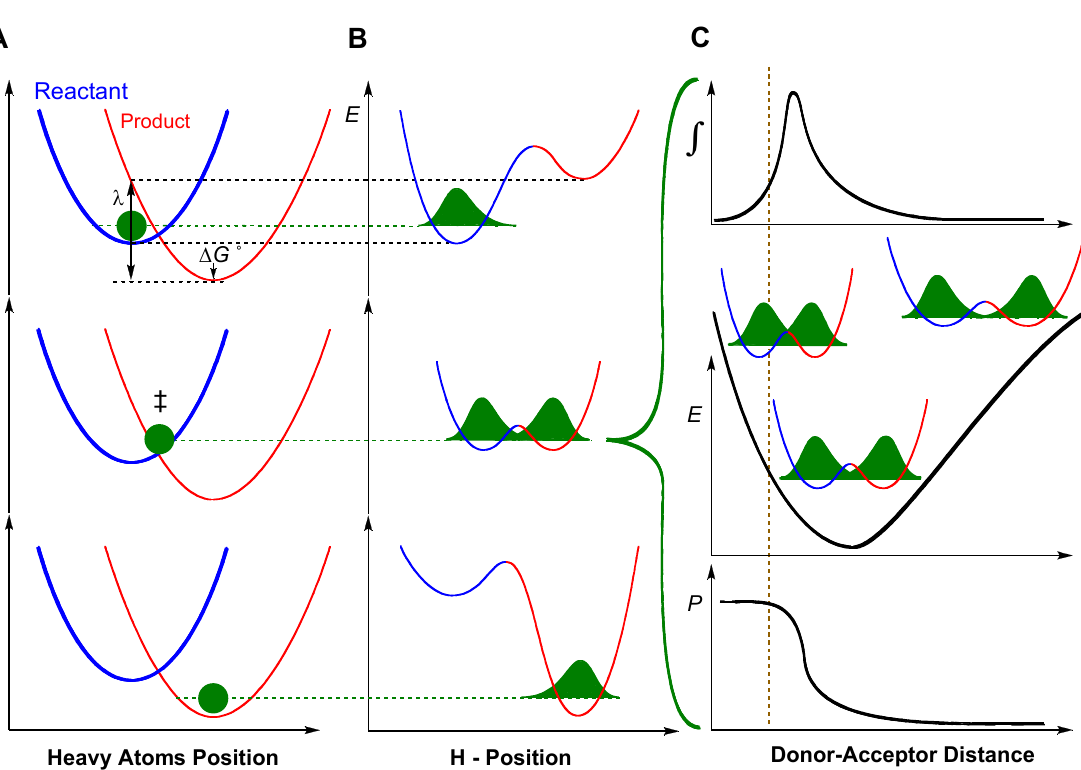
Figure 4. Marcus-Like models of hydrogen tunneling—a visualization of Equation (21). Three slices of the potential energy surface (PES) along components of the collective reaction coordinate showing the effect of heavy-atom motions on the zero point energy in the reactant (blue) and product (red) potential well. Panel A presents the heavy atom coordinate (also known as the Marcus parabolas), and Panel B shows the H-atom position, which is orthogonal to the heavy atom coordinate. In the top panels the hydrogen is localized in the reactant well, and the zero point energy of the product state is higher than that of the reactant state. Heavy atom reorganization brings the system to the tunneling ready state (TRS, middle panels A and B ), where the zero point energy in the reactant and product wells are degenerate and the hydrogen can tunnel between the wells. Further heavy atom reorganization breaks the transient degeneracy and traps the hydrogen in the product state (bottom panels). The rate of reaching the TRS depends on the reorganization energy ( λ ) and driving force ( Δ G°), which are indicated in the top panel, and further discussed under Equation (21). Panel C shows the effect of DAD sampling on the wave function overlap at the TRS (middle panel). Transmission probability ( P ) is a function of the overlap integral of the hydrogen wave functions in the reactant (blue) and product (red) wells (bottom panel C ). The top panel C presents the contribution to H-transfer at each DAD as a function of the P and the population at each DAD ( i.e. , the integrated terms in Equation (21)). The vertical dashed line represents the DAD under which the ZPE is greater than the barrier height. At such distances, the process of a wave function spreading from reactant well to product well is no longer “tunneling”, but one can still use the particle’s transmission probability analogously to the tunneling probability at longer